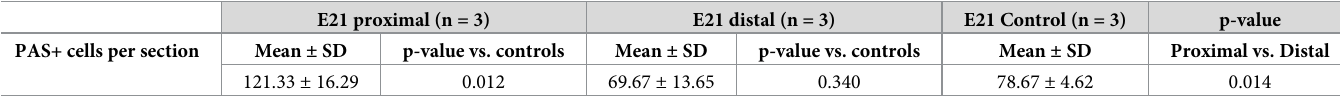
Table 5. Goblet cells in the epithelium at ED21. The number of goblet cells was significantly increased in the proximal segment compared with the ED21